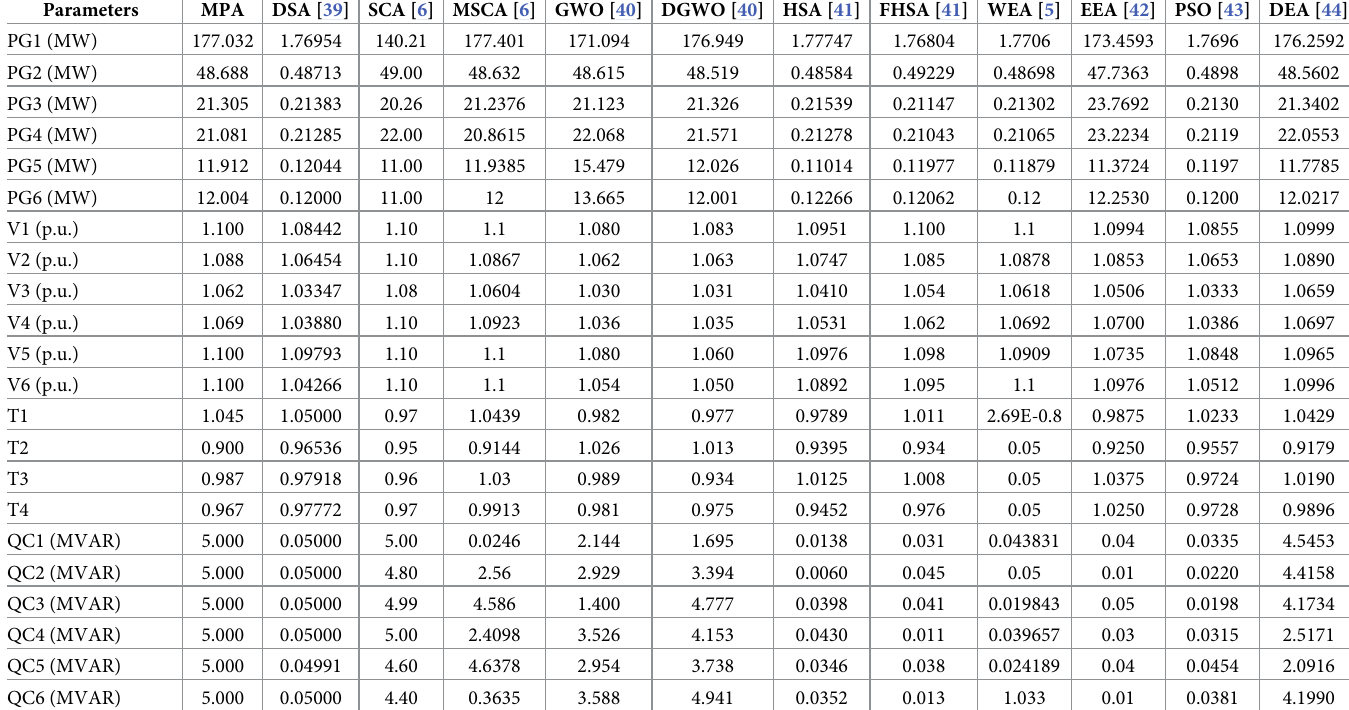
Table 2. Comparison of proposed algorithm with other literature work for case 1.